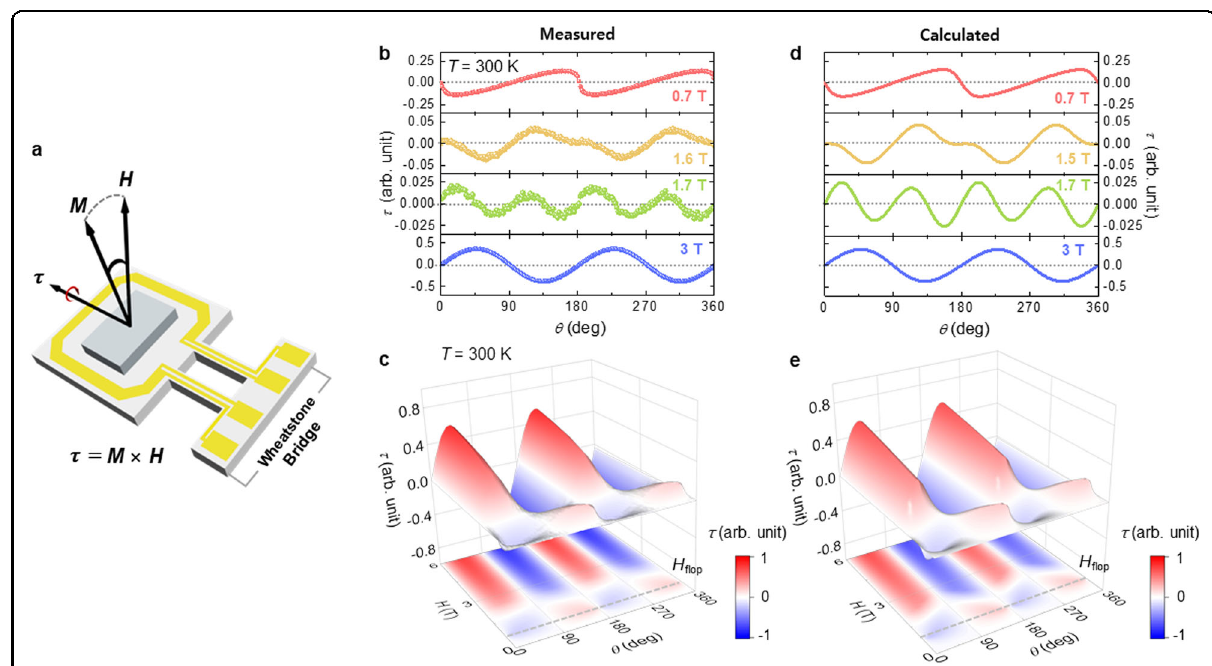
Fig. 4 Measured and calculated magnetic torques at room temperature. a Schematic of the magnetic torque measurement using a piezoresistive cantilever connected to a Wheatstone bridge circuit. H deviating from the c -axis by the angle θ is rotated. b Angle dependence of the magnetic torque per unit volume, τ = M × H , measured at T = 300 K and H = 0.7, 1.6, 1.7, and 3 T. The scale of τ at 9 T is ten and twenty times larger than the scales at 1.6 and 1.7 T, respectively. c 3D contour plot of the angle-dependent τ data measured at different H and T = 300 K. d Angle dependence of τ estimated from the uniaxial anisotropic spin model at H = 0.7, 1.5, 1.7, and 3 T. e 3D contour plot constructed from the angle- dependent τ data calculated at different H